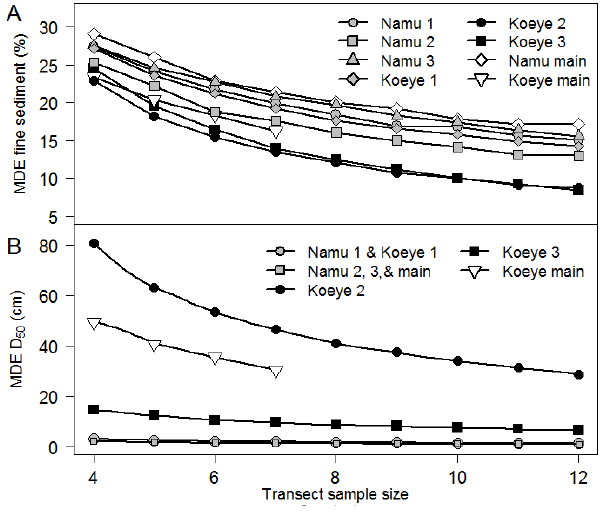
Fig. 3 . Minimum detectable effect (MDE) size for percent fine sediment (Panel A) and median particle size, or D50 (Panel B), as a function of sample size with statistical power of 0.8 and significance level of 0.05. Lines with grey points represent low gradient riffle-pool streams, black points represent high gradient cascade-pool streams, and white points indicate large, low gradient streams. D50 results for Koeye 1, Namu 3, and Namu main are combined under Namu 1 and Namu 2, respectively, because nearly identical MDE values were obtained. The MDE for Koeye Main could be predicted up to n = 7 because only seven transects could be completed at that